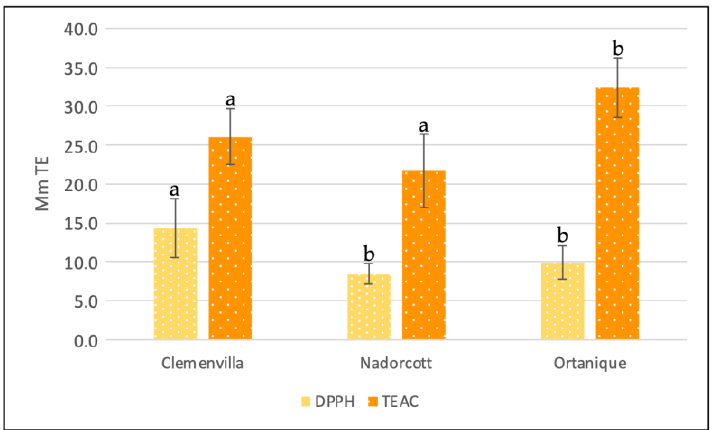
Figure 2. Differences in antioxidant capacity assessed by DPPH and TEAC assays in hybrid mandarin peels. a,b: different letters in the same color indicate that there are statistically significant differences ( p < 0.05) between the values. TE: Trolox equivalent.